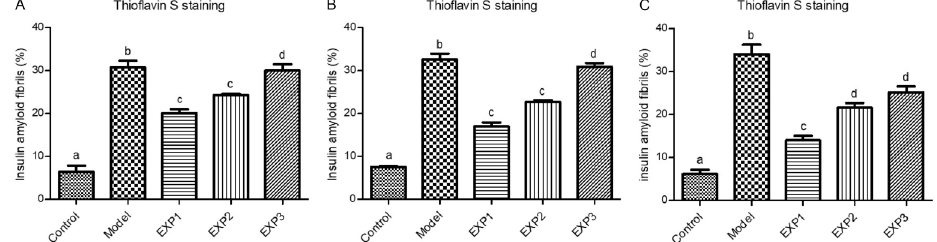
Figure 11. Quantitative analysis of Figure 10 data. Control group had healthy neurons, model group showed neuronal damage, and treated groups had mild neuronal injury. In all groups, data were obtained from 5 different animal specimens with 5 random slides and are reported as means ± SE. Different letters indicate statistically signi fi cant differences (ANOVA). A , Percentage of insulin amyloid fi brils in the presence and absence of trans- chalcone in the dentate gyrus region, ( B ) in the presence and absence of silibinin in the dentate gyrus region, and ( C ) in the presence and absence of silibinin in the cornu ammonis region. See Table 1 for group description.